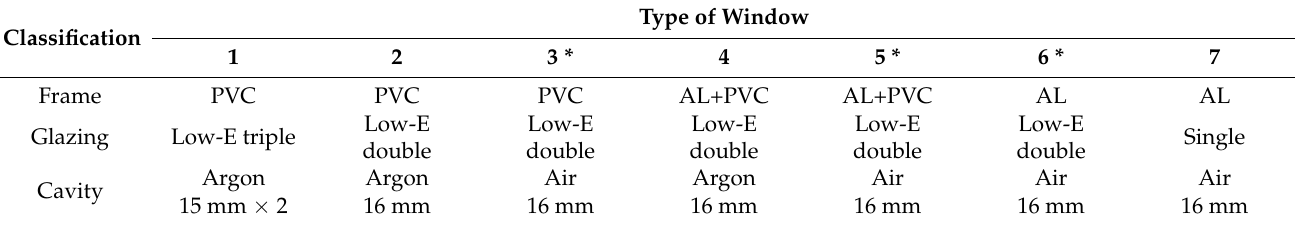
Table 3. Description of window configurations. AL, aluminum; PVC, polyvinyl chloride.